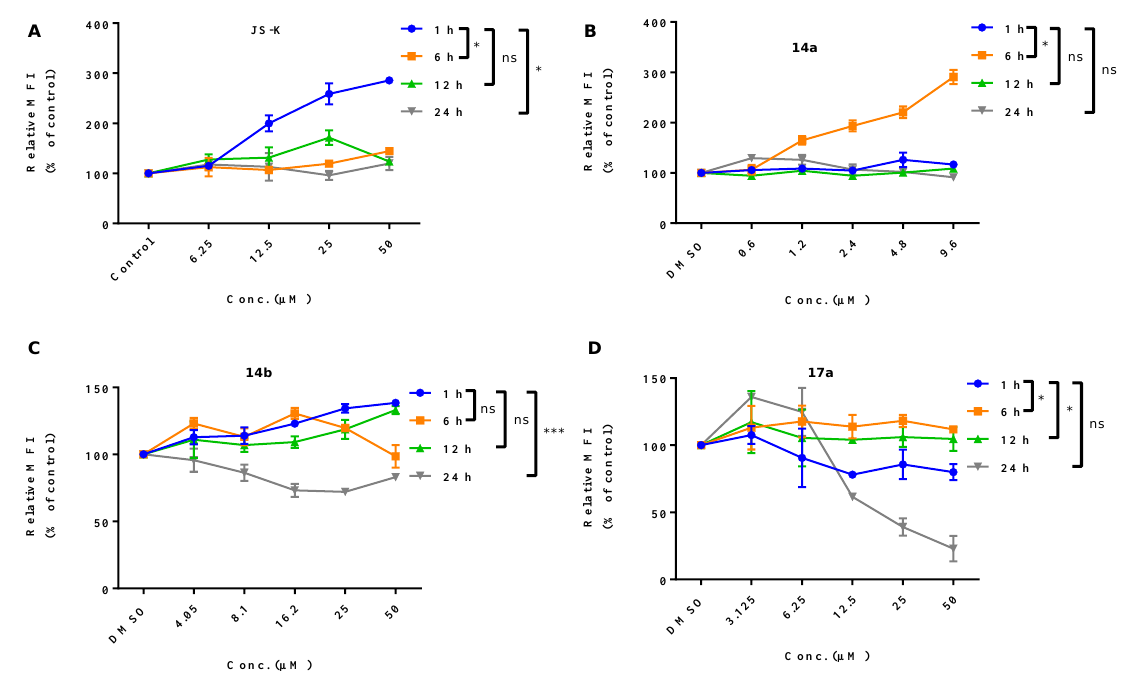
Figure 6. Intracellular NO release in HepG2 as measured by DAF-FM DA assay: ( A ) JS-K (reference prodrug); ( B ) NO- ∆ -16-CIEA 14a ; ( C ) NO- ∆ -16-CIEA 14b ; ( D ) NO- ∆ -16-CIEA 17a . Values reported are averages ± SD of at least two measurements. * p ≤ 0.05, ** p ≤ 0.01, *** p ≤ 0.001, ns : nonsignificant.